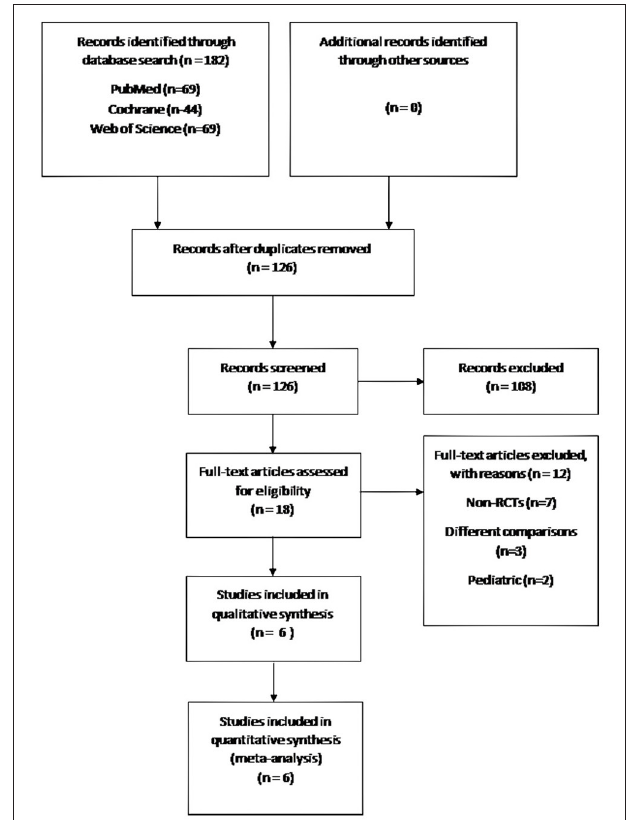
FIGURE 1 | Study flow